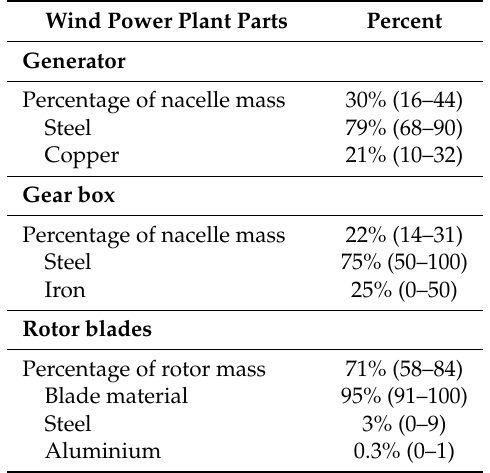
Table E1. Mean material specification for commonly replaced components; Generator, gear box and rotor blades, as well as each component’s mass percentage of main part. [47,50,51] Smallest to largest percentages found are shown in parenthesis.